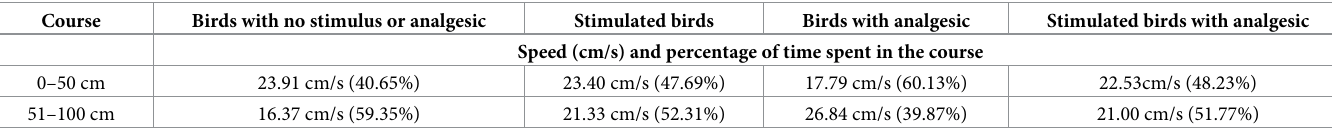
Table 3. Distribution of speed (cm/s) and percentage of time for each category of broiler chickens, the first and second half of the course. Course Birds with no stimulus or analgesic Stimulated birds Birds with analgesic Stimulated birds with analgesic Speed (cm/s) and percentage of time spent in the